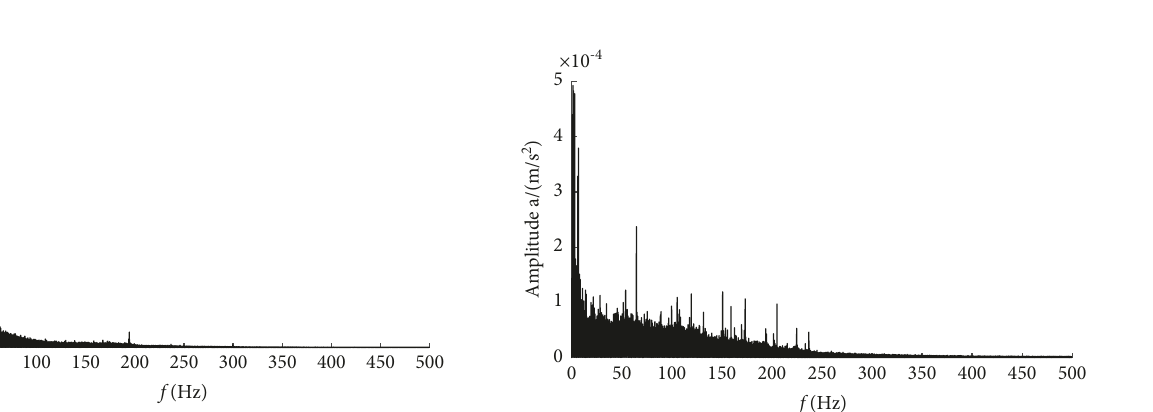
Figure 12: The envelope spectrum of the raw signal of a vibration signal from class 3.